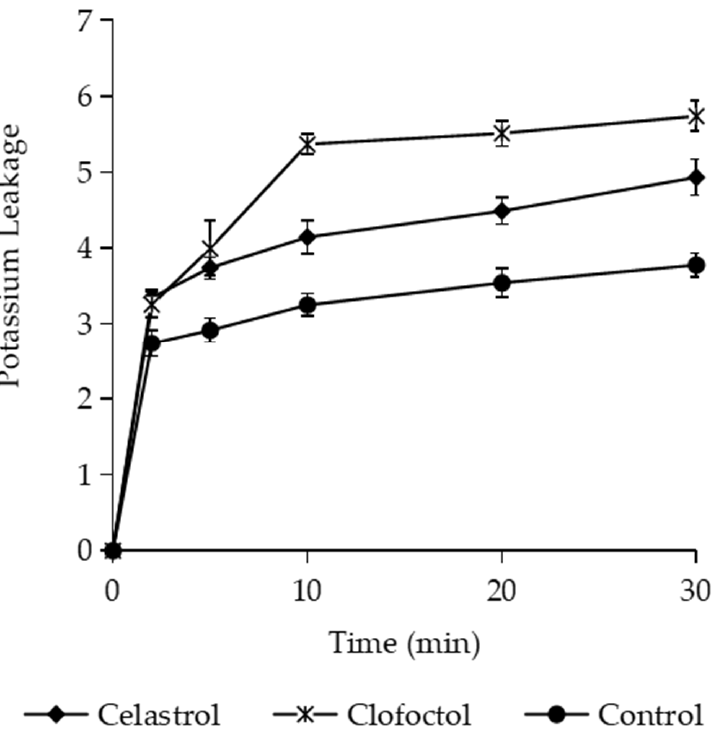
Figure 7. Potassium (K + ) leakage ( µ g/mL) from Bacillus subtilis cells exposed to celastrol (3 µ g/mL). Cultures with clofoctol (5 µ g/mL) or the maximum proportion of DMSO were used as positive and negative controls, respectively. Error bars express SD with n = 3.